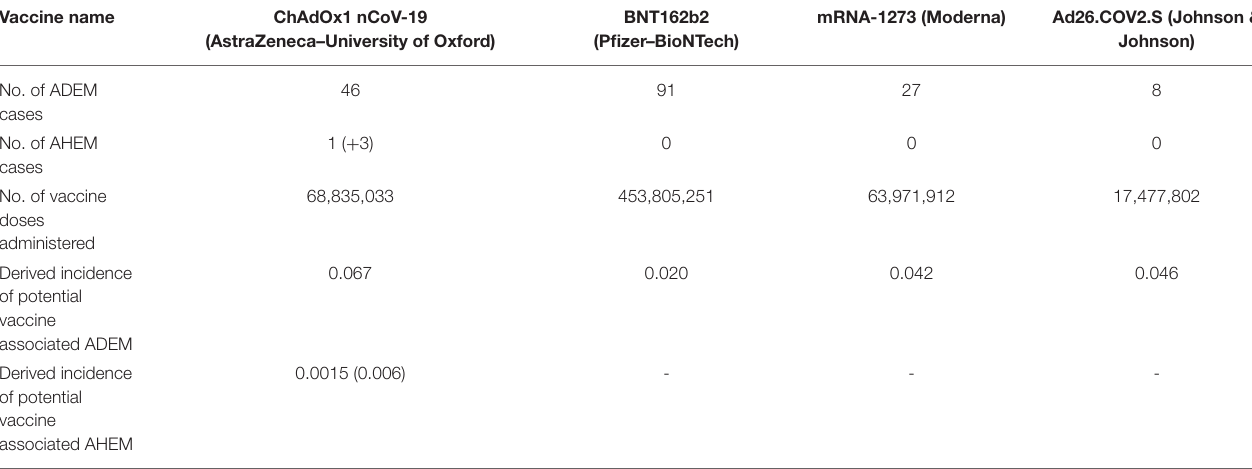
TABLE 1 | Reported number of potential vaccine-related adverse effects in European Economic Area (EEA) countries associated with the terms “acute disseminated encephalomyelitis” or “acute haemorrhagic leukoencephalitis” in the European Medicines Agency’s (EMA) EudraVigilance database by 20th November